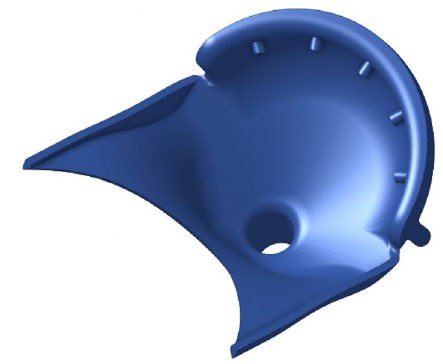
Fig. 3 Design of a urine funnel—an isometric